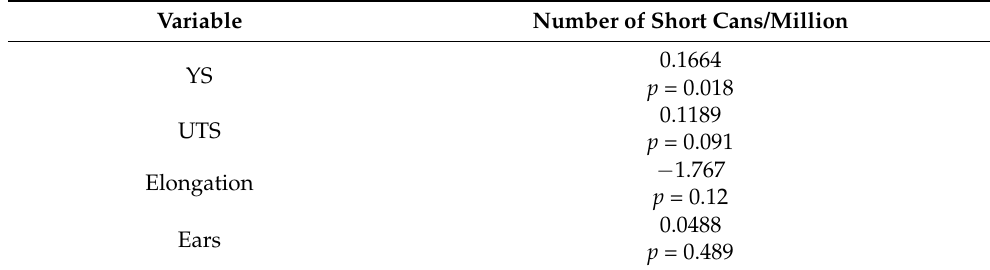
Table 3. Correlation between the mechanical parameters and the index of short cans for all